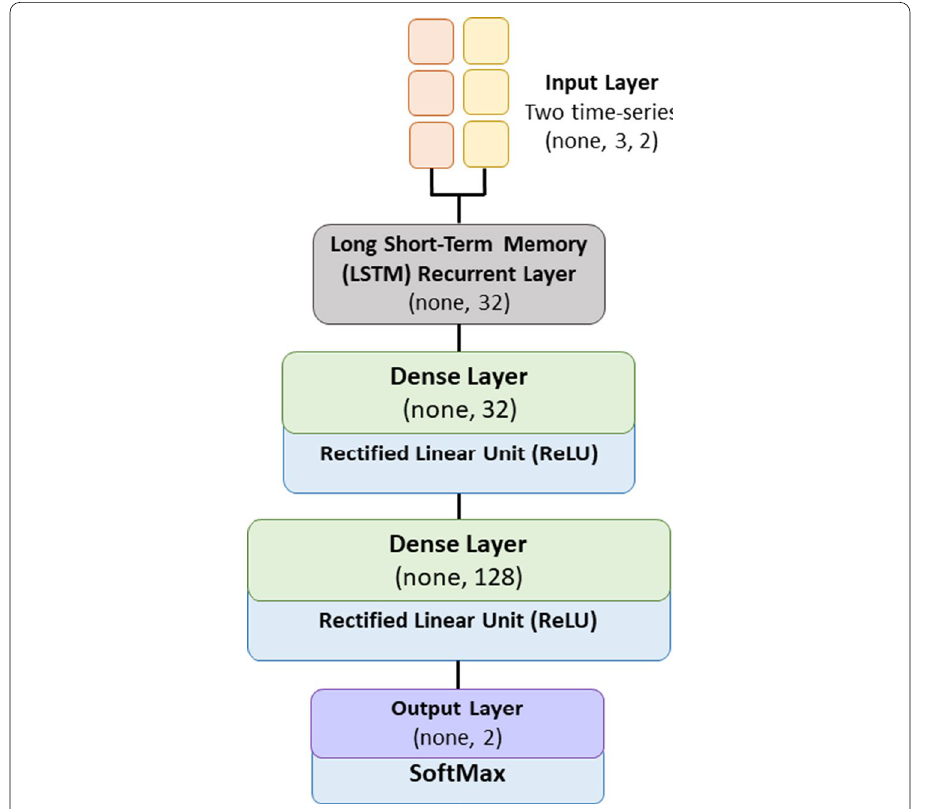
Fig. 4 Structure of the deep learning model